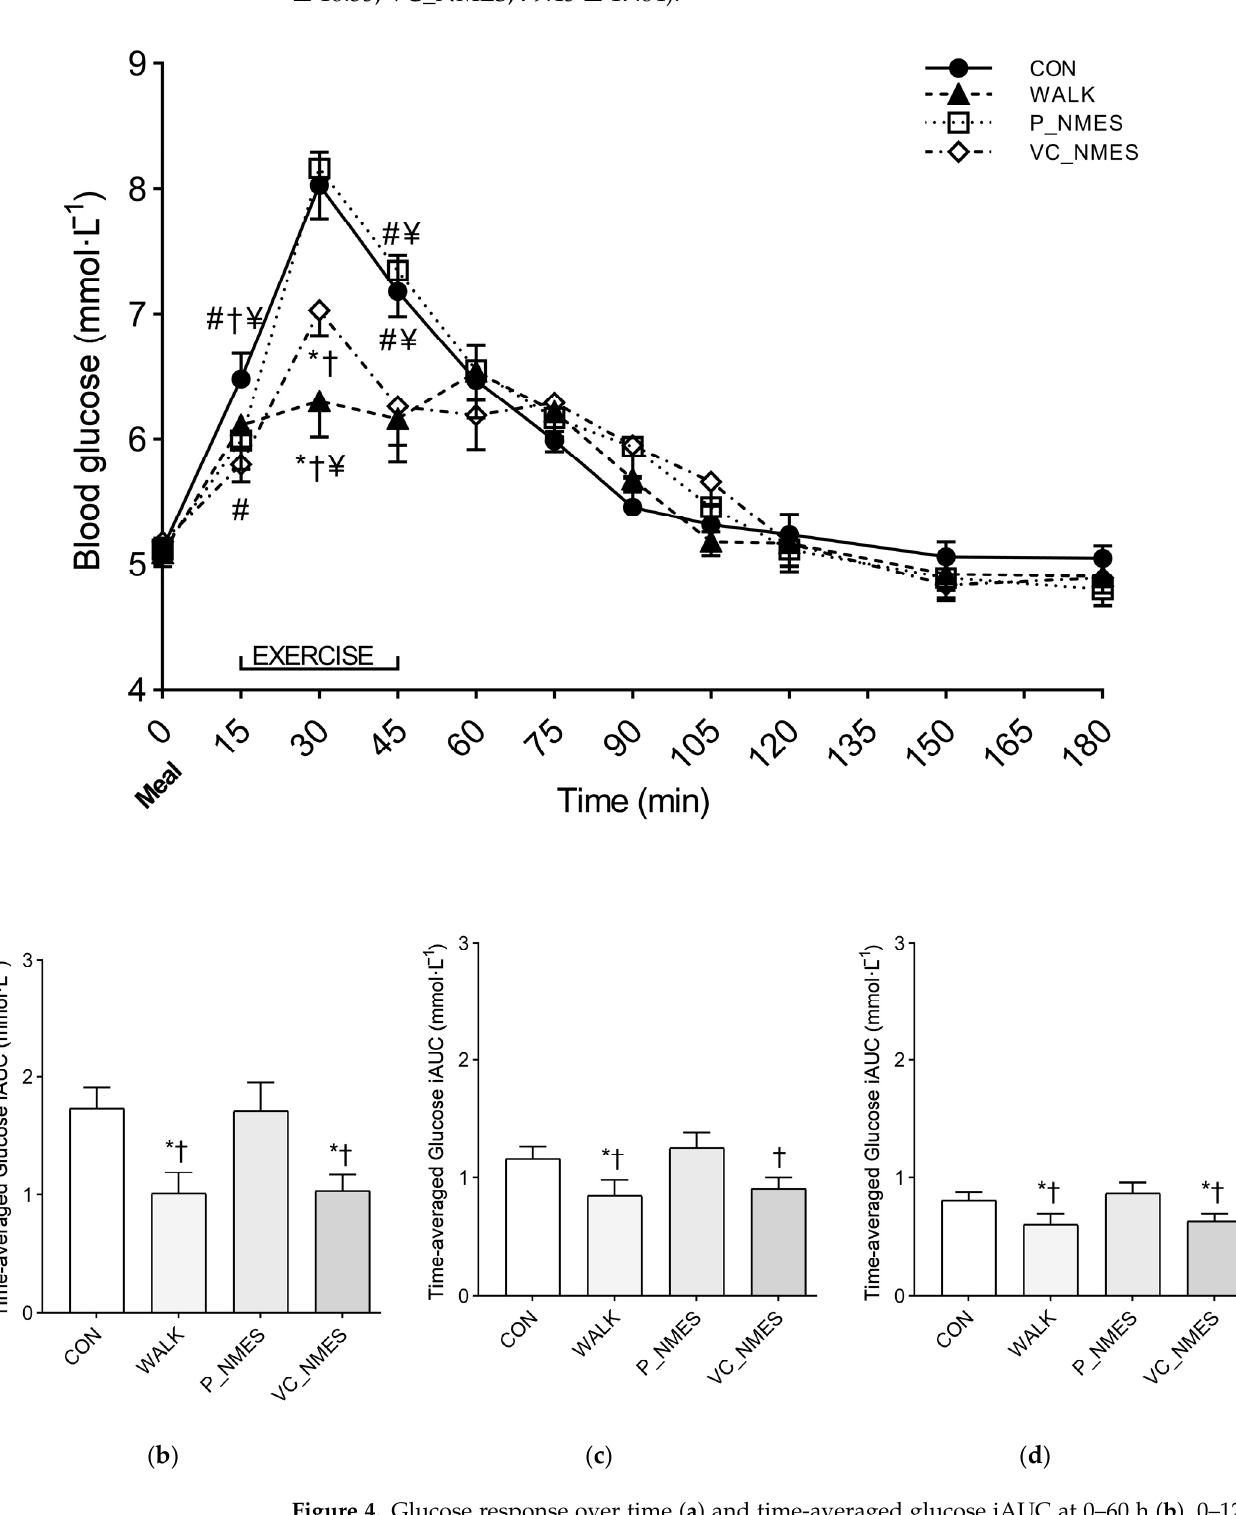
Figure 4. Glucose response over time ( a ) and time-averaged glucose iAUC at 0–60 h ( b ), 0–120 h ( c ), 0–180 h, and ( d ) after the meal for Study 2. Symbols: *, p < 0.05 vs. CON; #, p < 0.05 vs. WALK; †, p < 0.05 vs. P_NMES; ¥, p < 0.05 vs. VC_NMES. Values are reported as mean (± SEM). Significant between-condition differences were found for the iAUC at 0–60 ( p < 0.001, η p 2 = 0.562), 0–120 ( p = 0.004, η p 2 = 0.360), and 0–180 min ( p = 0.004, η p 2 = 0.352). Significantly lower iAUC values were found at 0–60 ( p < 0.003), 0–120 ( p < 0.011), and 0–180 ( p < 0.015)